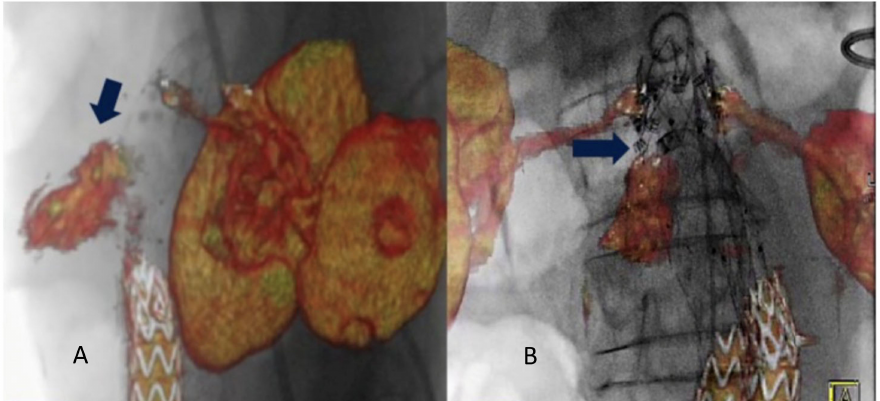
Figure 3. Intraoperative projection of type IA endoleak channel ( A ). Positioning and deployment of the Heli-FX endo-anchors in the specific origin of the endoleak (arrow) for the “endosuture line” ( B ) from Tinelli et al.